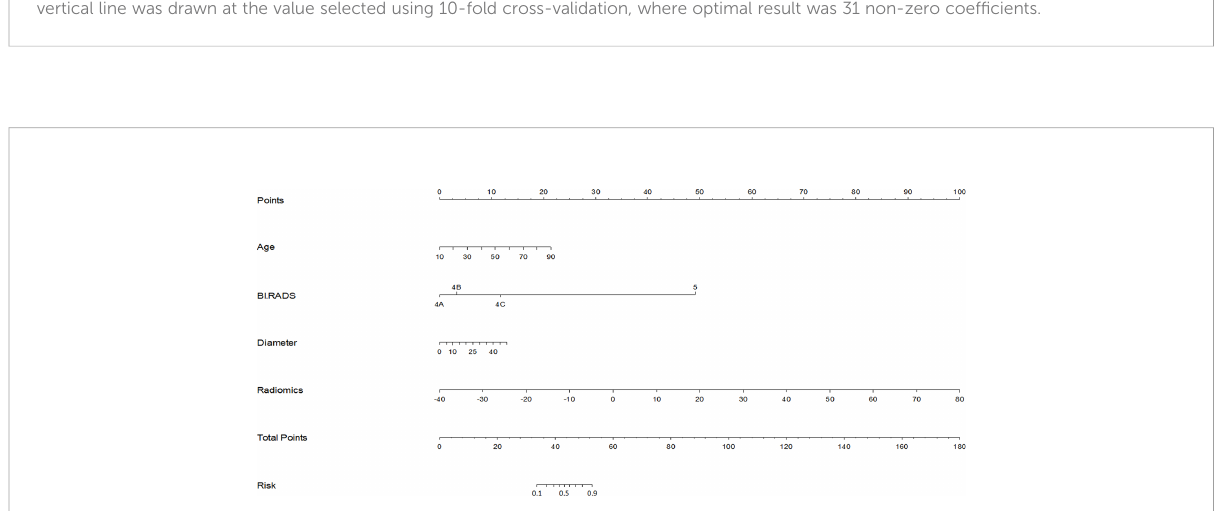
FIGURE 5 Nomogram for prediction of BC in BI-RADS US category 4 or 5 lesions. The different values for each variable corresponds to a point at the top of the graph, while the sum of the points for all the variables corresponds to a total point, draw a line from the total points to the bottom line is the probability of BC in BI-RADS US category 4 or 5 lesions.The AUC of the model constructed with radiomics score, patient age, lesion diameter identi fi ed by US and BI-RADS category involved was